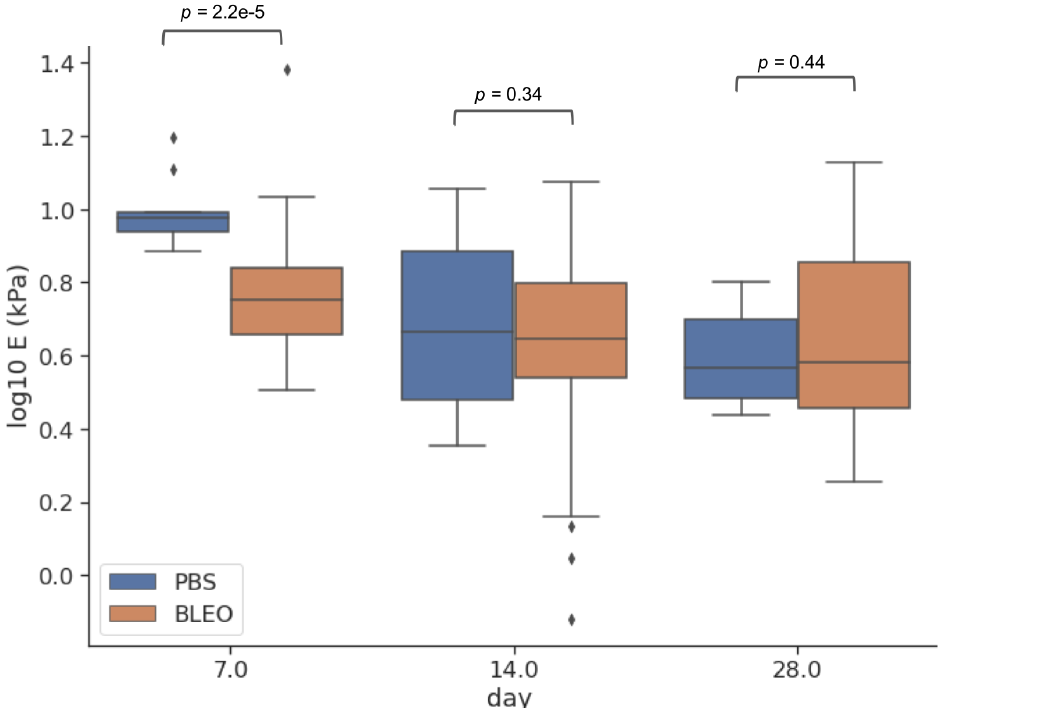
Figure 1. Young’s Modulus ELR measured by AFM. Boxplots represent the distribution of the data at days 7, 14, and 28 after instillation. The centre line in the boxplots represents the median value, the top and bottom limits of the box represent Q1 and Q3 of the data. Whiskers represent minimum and maximum values, the diamonds represent outliers and are data points outside 1.5 times the interquartile range. ( n = 15 for control and n = 35 for fibrotic, corresponding to 5 maps per